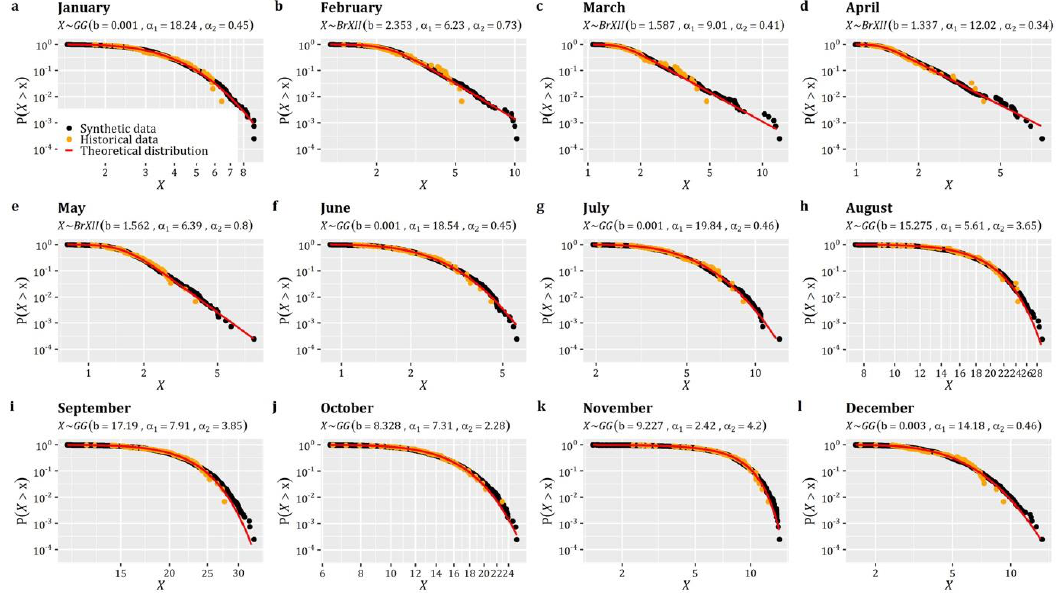
Figure 13. Monthly-based ( a – l ) comparison of empirical, simulated, and theoretical distribution functions. The title of each subplot provides the selected distribution and its parameters.